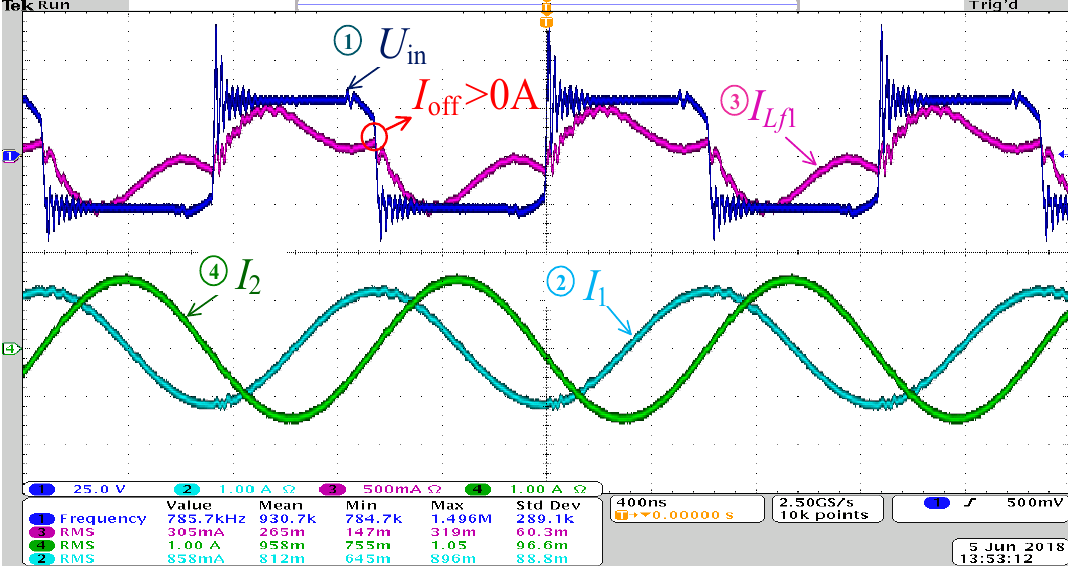
Figure 7. Experimental results of waveforms of the input and output of the coupling resonator.